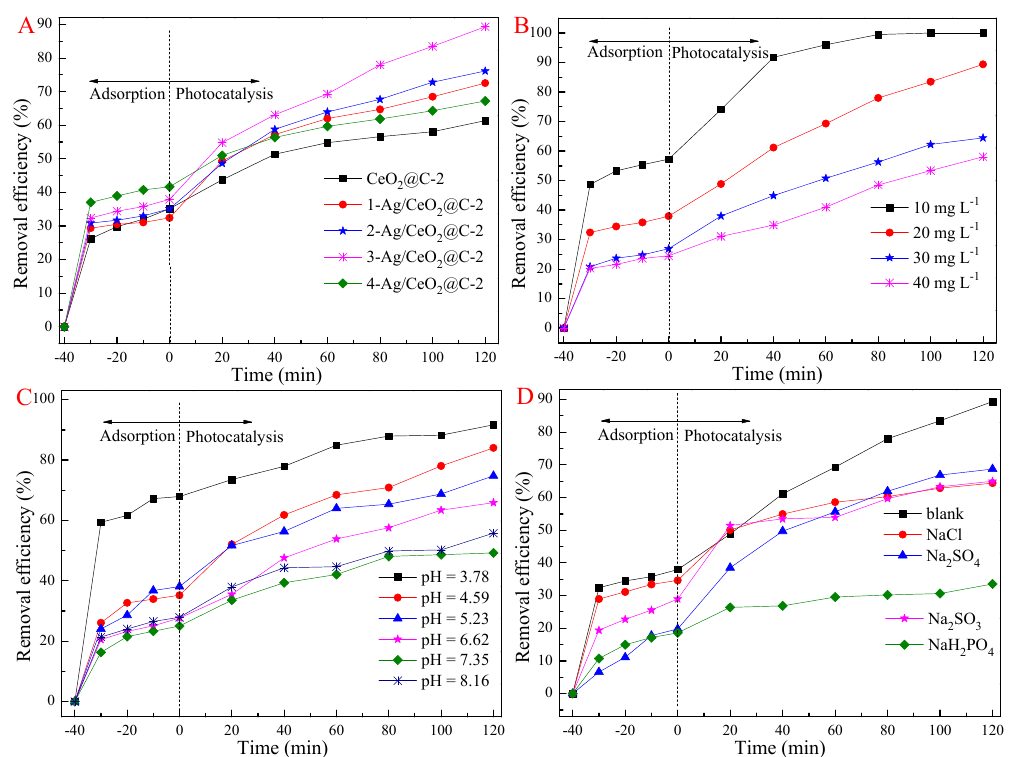
Figure 7. Effect of Ag content on the photocatalytic activity of CeO 2 @C-2 ( A ) and the effects of Cr(VI) concentration ( B ), pH value ( C ), and inorganic ions ( D ) on the photocatalytic activity of 3-Ag / CeO 2 @C-2. − − − − Inorganic ions such as chlorine (Cl ), sulfite (SO 32 ), sulfate (SO 42 ), and phosphate (H 2 PO 4